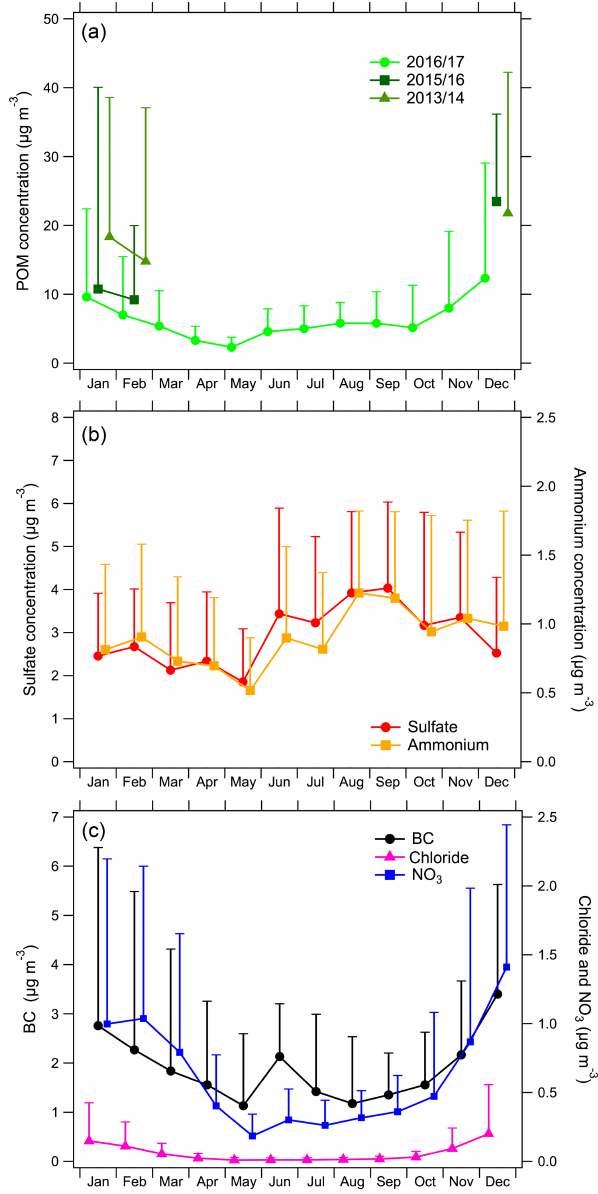
Figure 3. Monthly average concentrations of the main aerosol con- stituents. Organics are shown in (a) for the 2016–2017 period as well as the 2013–2014 and 2015–2016 winter periods, while sulfate and ammonium are shown in (b) and BC, nitrate, and chloride are shown in (c) for the 2016–2017 period. The standard deviation is also depicted (error bars; only the positive part is shown for the sake of